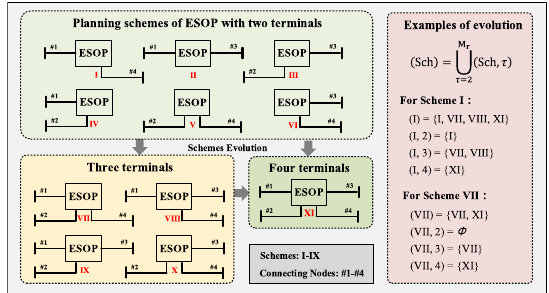
Fig. 2 Planning framework of ESOP in multiple